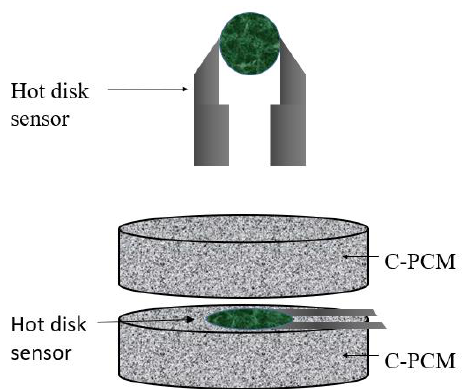
Figure 5. Schematic view of transient plane heat source method (adapted after [61] with permission form